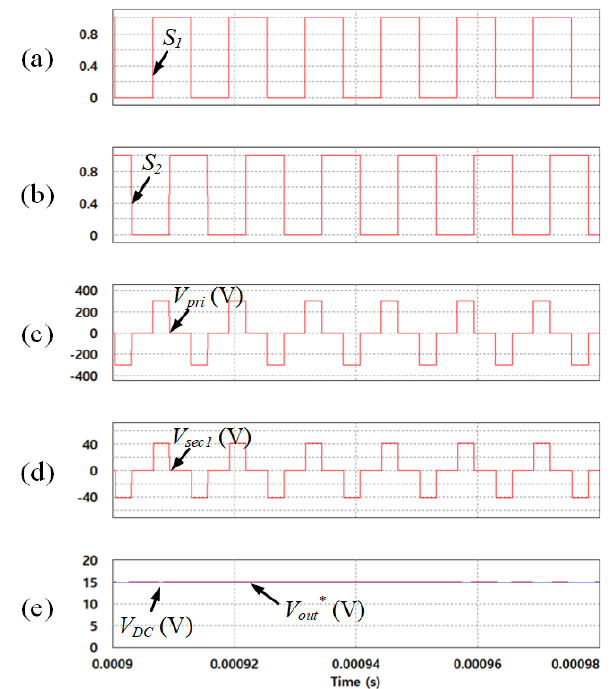
Figure 10. Simulation results about operation principle of the PSFB-CT converter. ( a ) Operation status of S 1 ; ( b ) Operation status of S 3 ; ( c ) Primary voltage of the transformer; ( d ) Secondary voltage of the transformer; ( e ) Output DC voltage and reference output voltage.